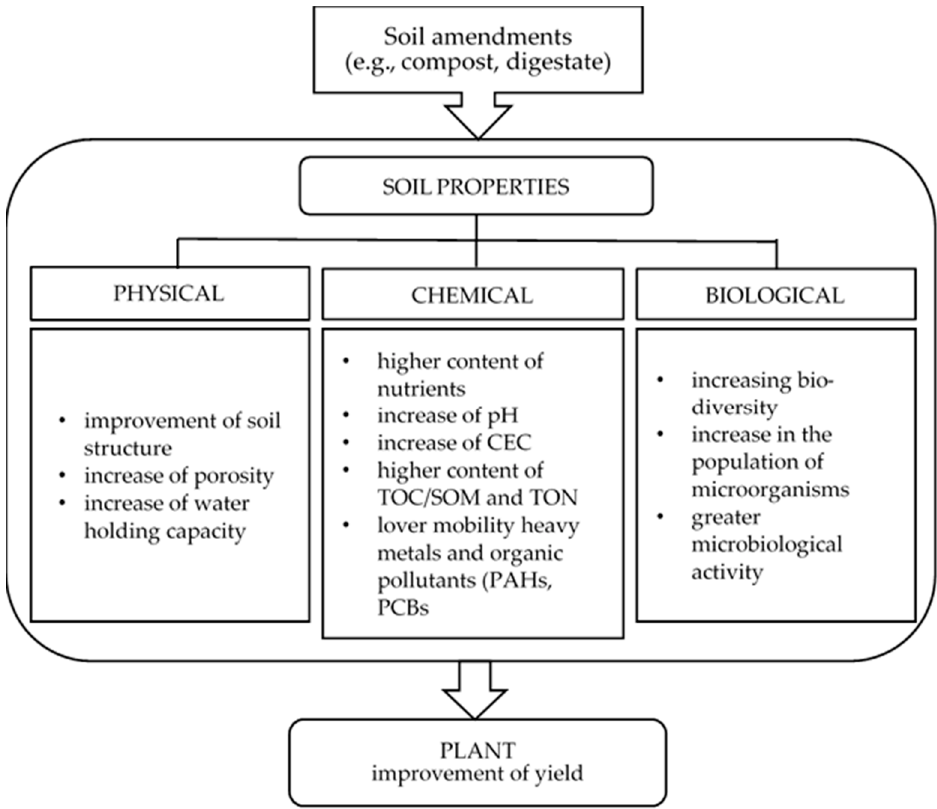
Figure 5. Effect of organic amendments application on soil properties and crops. Table 4. Effects of compost application on different soil properties.